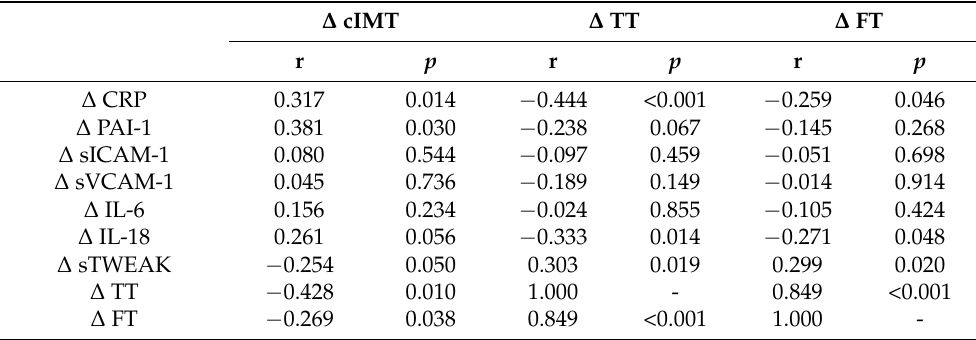
Table 3. Bivariate correlation of changes in inflammatory and endothelial biomarkers with cIMT and testosterone. ∆